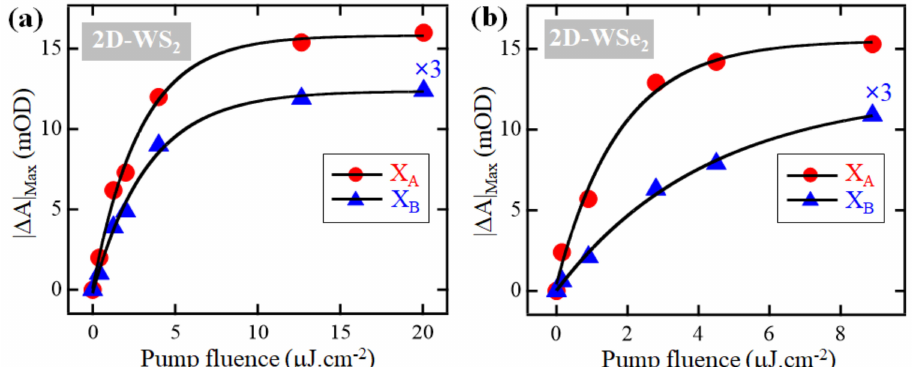
Figure 3. Dependence of the depletion signal maximal amplitudes of excitons X A and X B (magnified by 3) on the excitation fluence (symbols): ( a ) For 2D-WS 2 ; ( b ) For 2D-WSe 2 . Solid lines are fits with a single exponential growth function to guide the